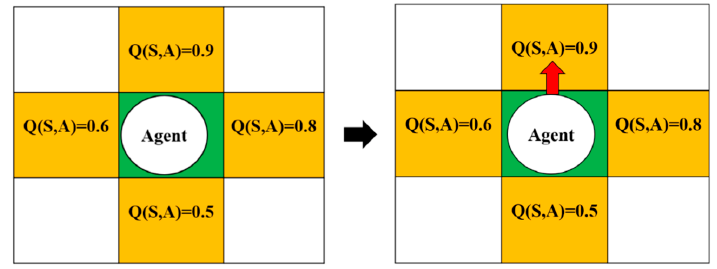
Figure 7. Operation of the greedy policy.